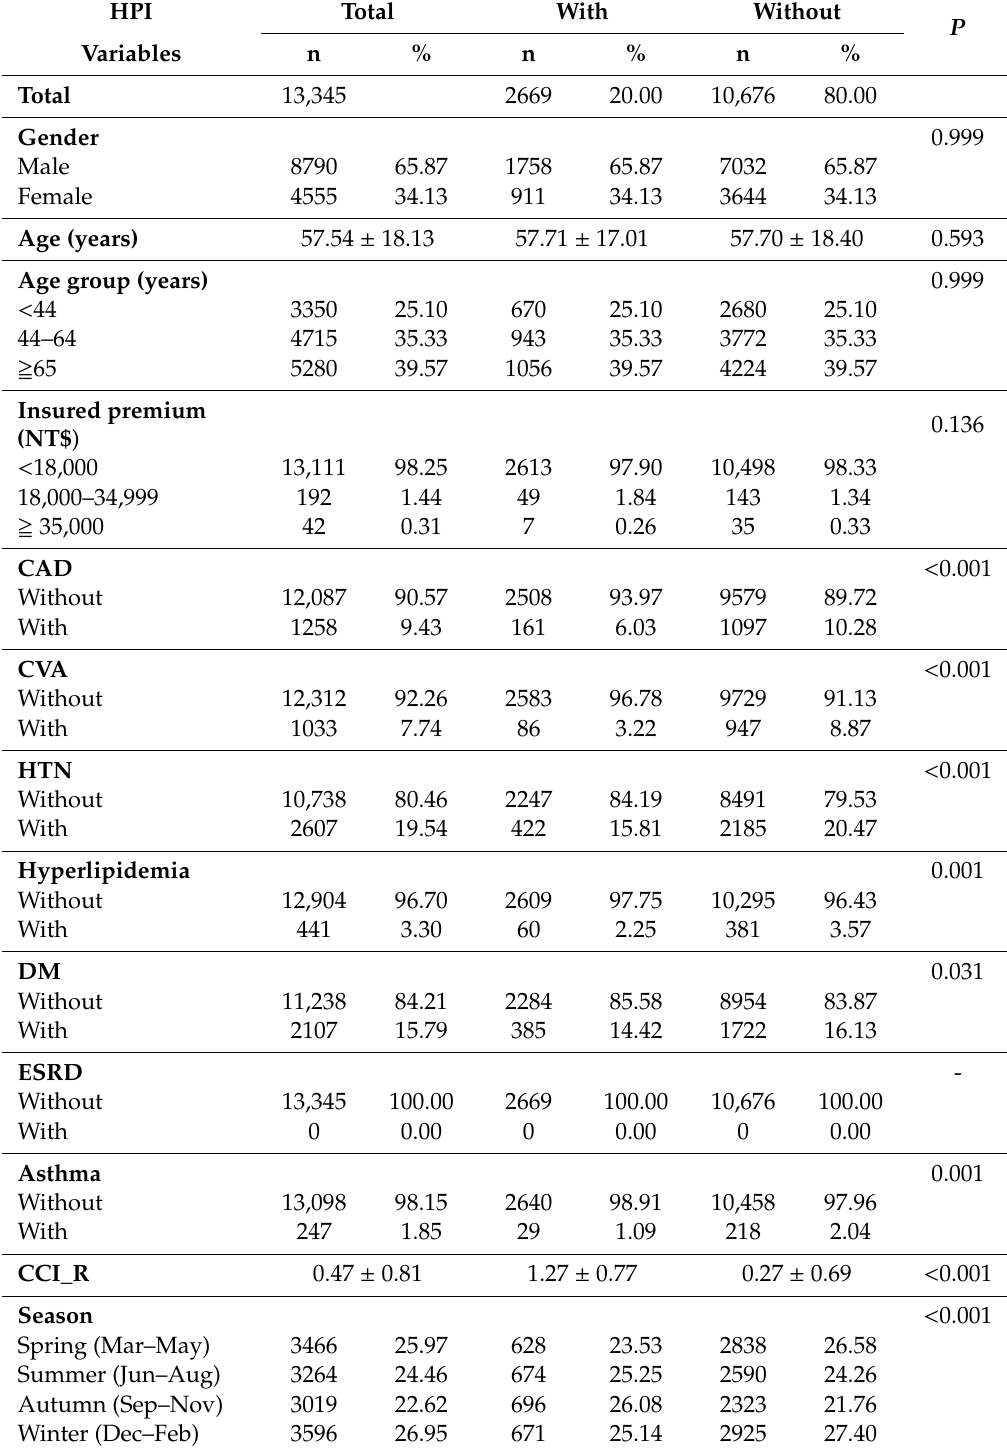
Table 1. Characteristics of the study population at the